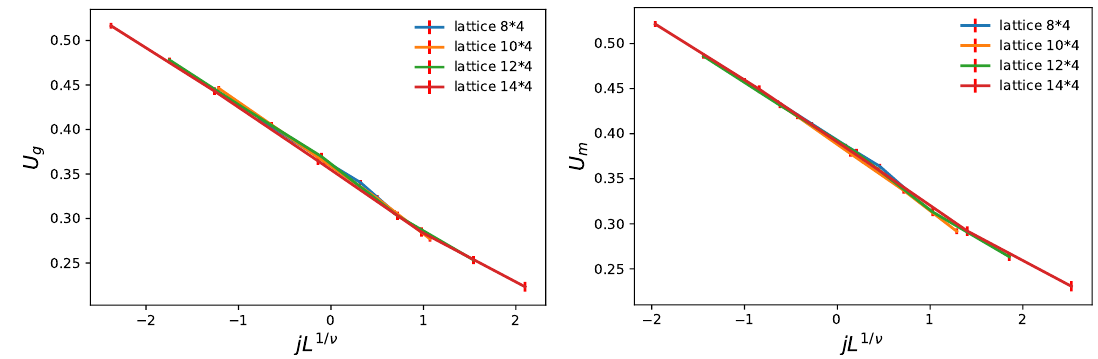
Figure 7 . The Binder cumulant for the gauge field order parameter (lhs.) and the matter order parameter (rhs.). We plot the results at β = β ∗ as a function of j L 1 /ν with j = J − J 2 and ν = 1 / 2 . We compare the results for different volumes L 4